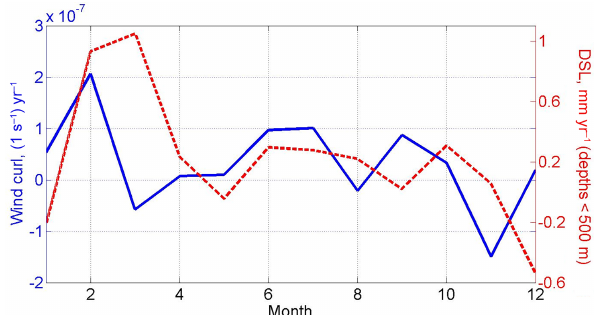
Figure 6. Monthly distribution of the wind curl (blue curve, 1s per year) and DSL trends (red curve, mmyr − 1 ) at the basin